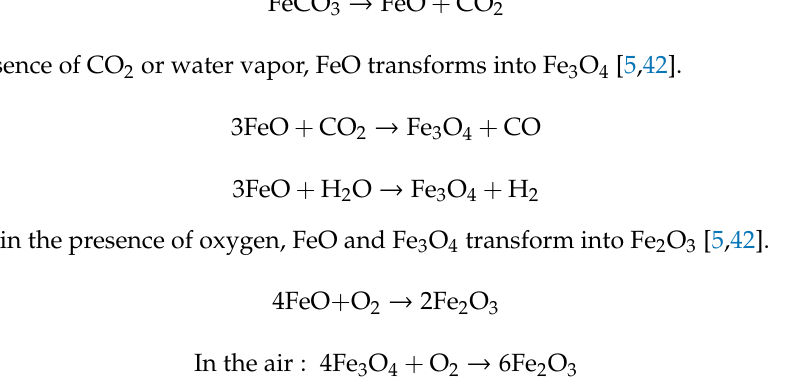
Figure 14. XPS spectra of the native gum Arabic: ( a , c , e , g ). XPS spectra of the film formed on the N80 carbon steel after 24 h exposure in CO 2 at P CO 25 ◦ C: ( b , d , f , h ).